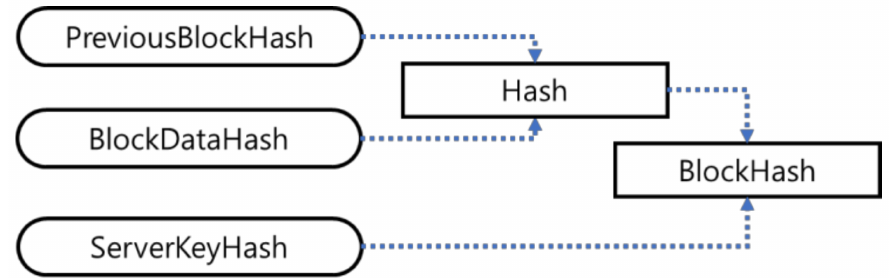
Figure 7. Merkle tree for light